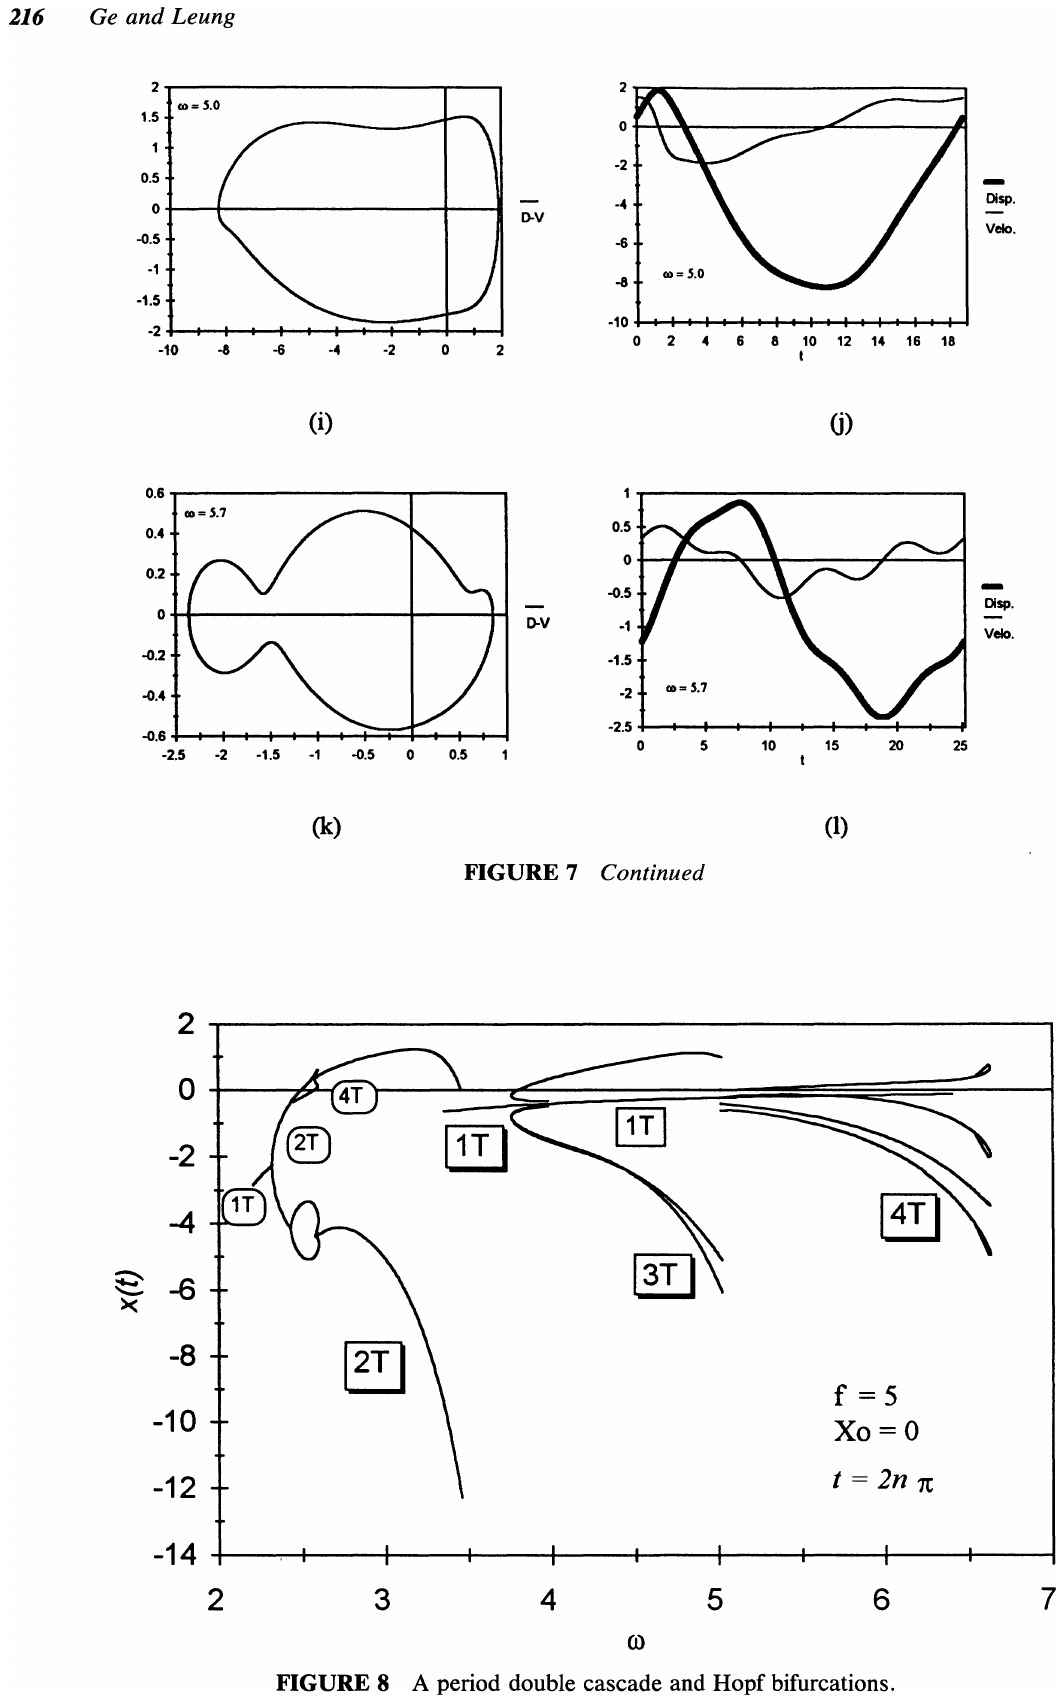
FIGURE 8 A period double cascade and Hopf